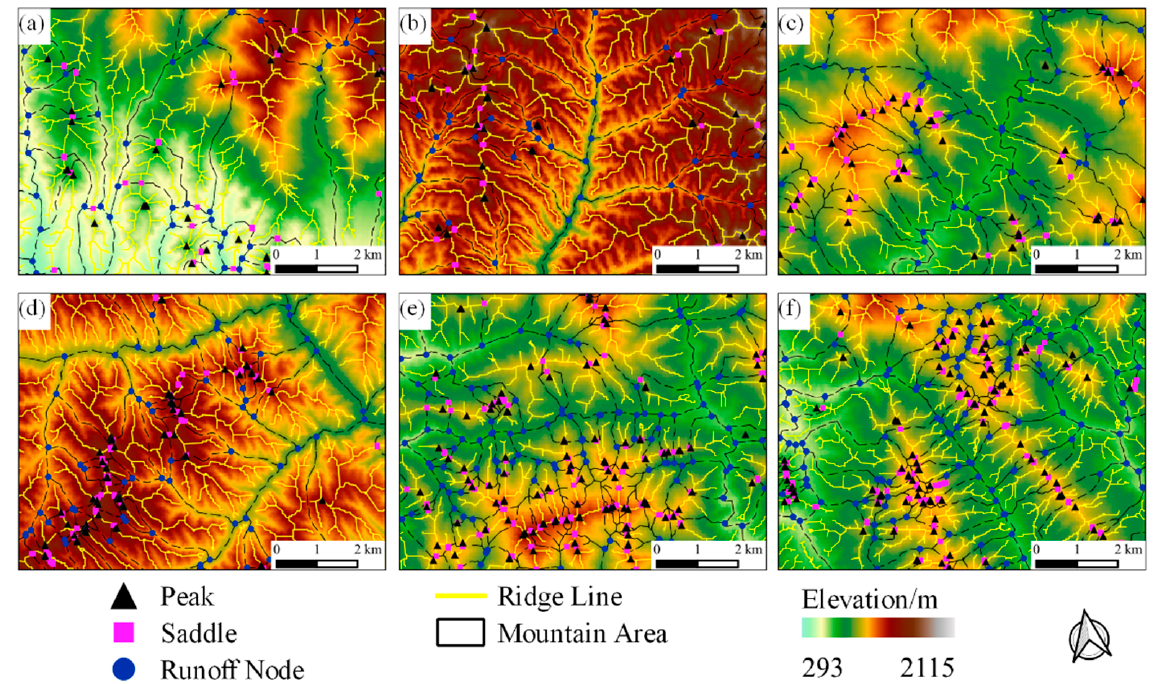
Figure 8. Validation of extracted point clusters by the ridgelines: ( a – f ) correspond to six typical sample areas, including Hanyin, Mizhi, Ningshan, Yanchuan, Zhen’an and Zhenba County, respectively; the black triangles, purple squares and blue dots represent peaks, saddles and runoff nodes, respectively; the yellow lines represent ridgelines, and the black dashed boxes represent the mountain control areas.